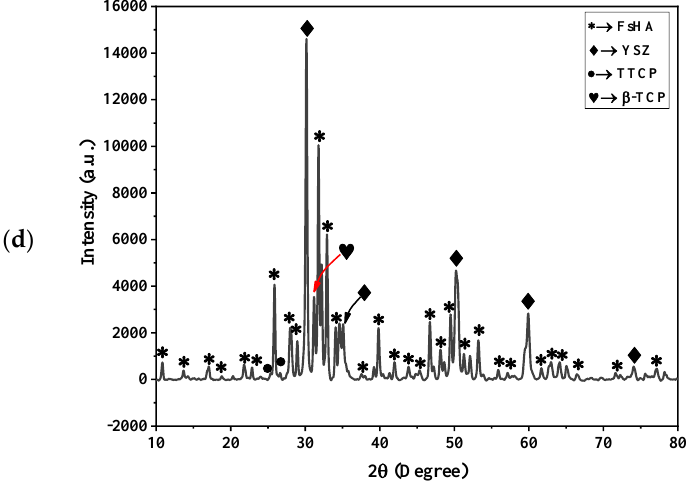
Figure 4. XRD patterns of FsHA powders with ( a ) 0 wt.% YSZ, ( b ) 10 wt.% YSZ, ( c ) 15 wt.% YSZ, and ( d ) 20 wt.% YSZ.